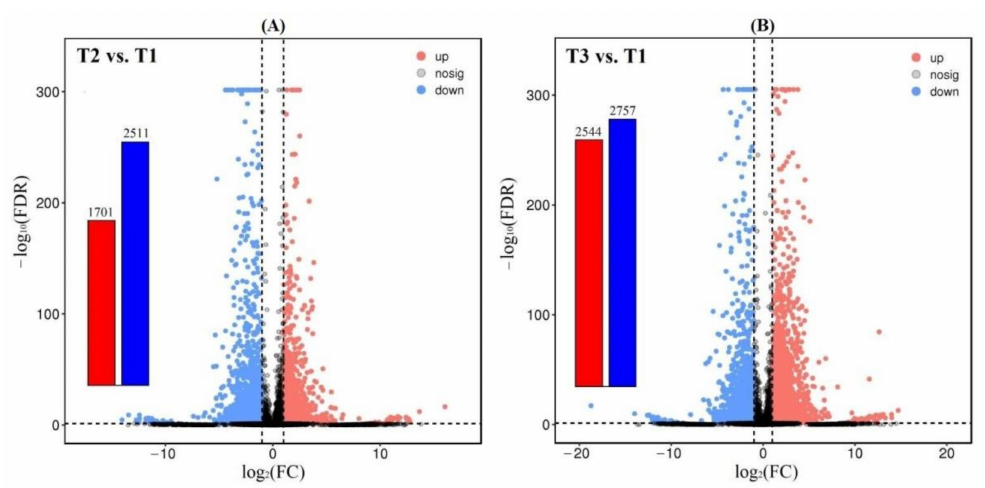
Figure 2. Volcano plot of differential expression at T2 vs. T1 ( A ) and T3 vs. T1 ( B ).